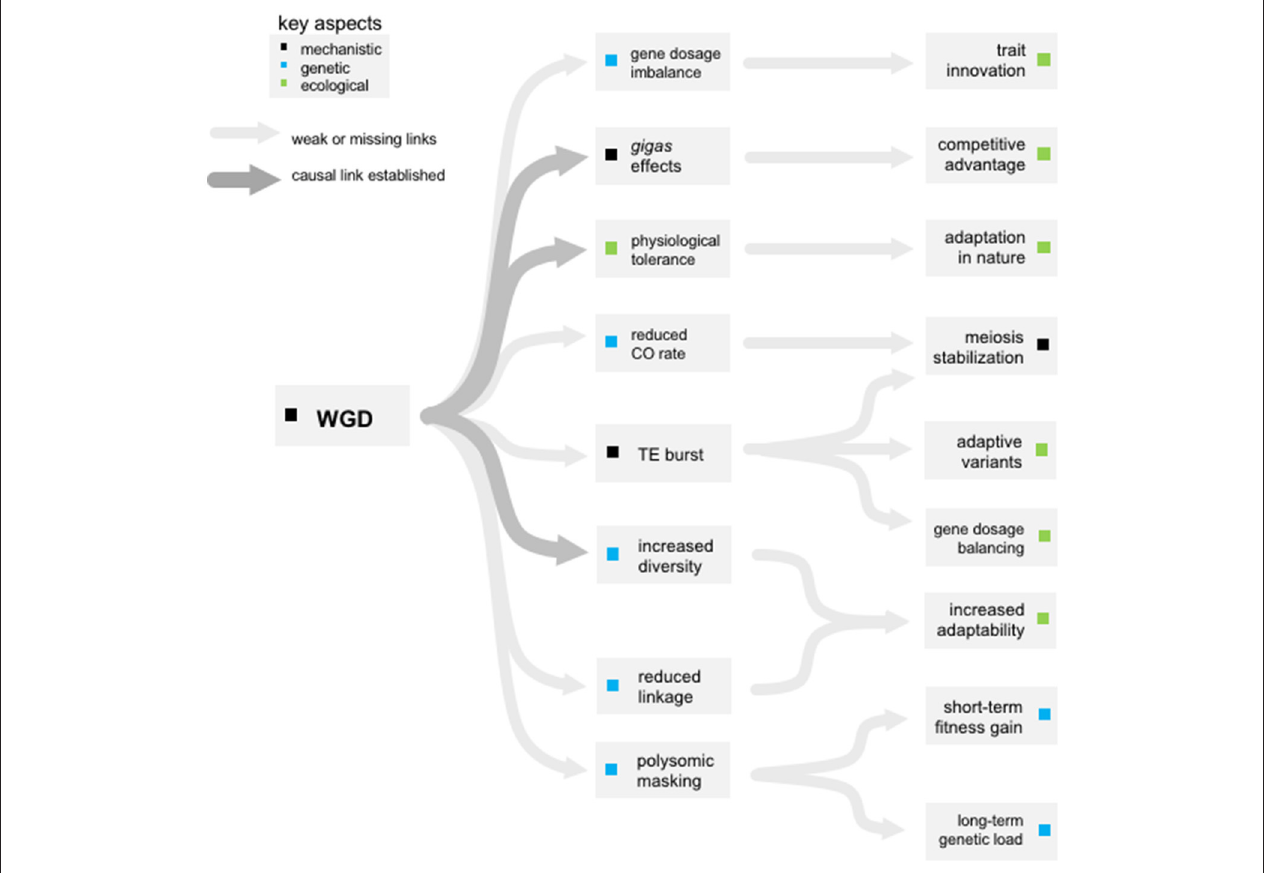
FIGURE 2 | The missing links. The major direct and indirect consequences of WGD either firmly established (dark gray) or still in need of experimental confirmation (light gray